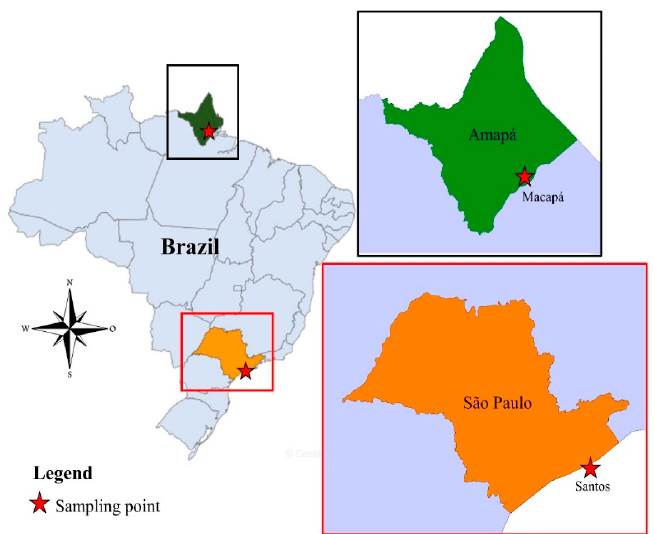
Figure 1. Location of the study area. From left to right: map of Brazil highlighting the state of Amapá and São Paulo, map of Amapá (Up) and São Paulo (down) showing the cities of Macapá and Santos, respectively.